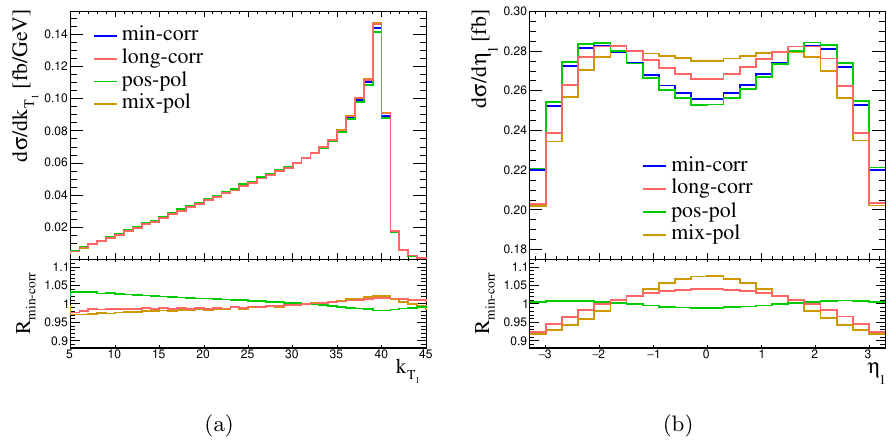
Figure 1 . The distributions of the muon transverse momentum and rapidity for the di(cid:11)erent models. The distributions for (cid:22) 2 are identical and are not shown. The ratio R min-corr shows the comparison of di(cid:11)erent models to the min-corr